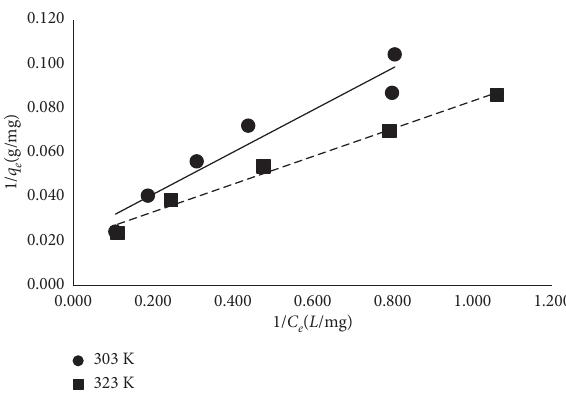
Figure 8: Langmuir sorption isotherm for the sorption of meth- ylene blue onto Ginkgo biloba leaves (temperature: 303 ° K and 323K; MB concentration: 30